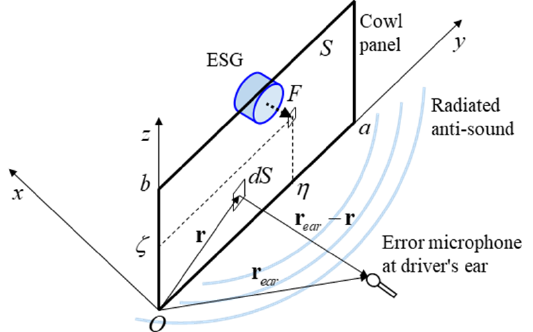
Figure 1. Radiated anti-sound from the cowl panel excited by the ESG propagating to the error microphone. Figure 1. Radiatedanti-soundfromthecowlpanelexcitedbytheESGpropagatingtotheerror microphone. At the ear location r ear = [ x ear y ear z ear ]